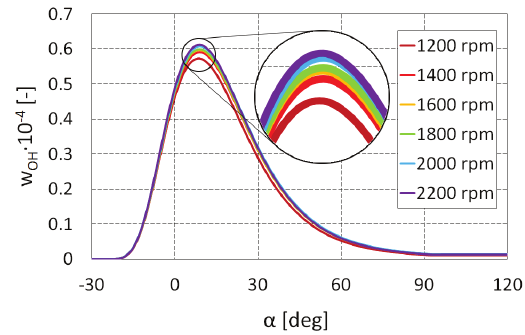
Fig. 7. Mass fraction of hydroxyl radicals – W OH for various engine speed (engine load 80%, methane content in fuel 40% (w/w)) The difference in simulated mass fractions of hydroxyl